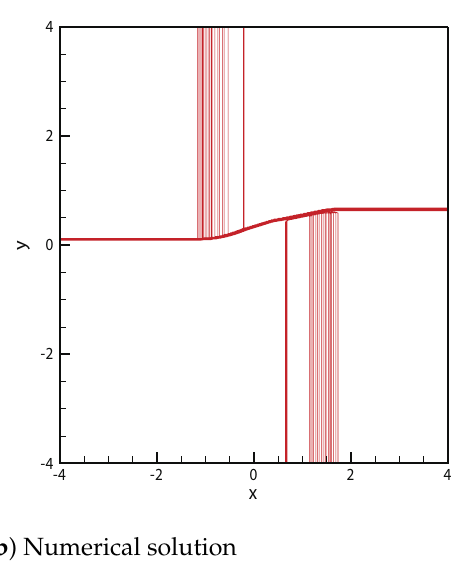
Figure 1. Case 1. JR + S δ + JR + S δ .